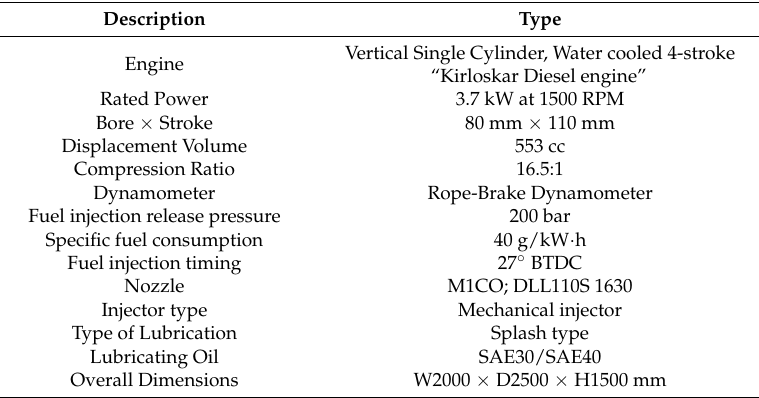
Table 2. Technical specifications of